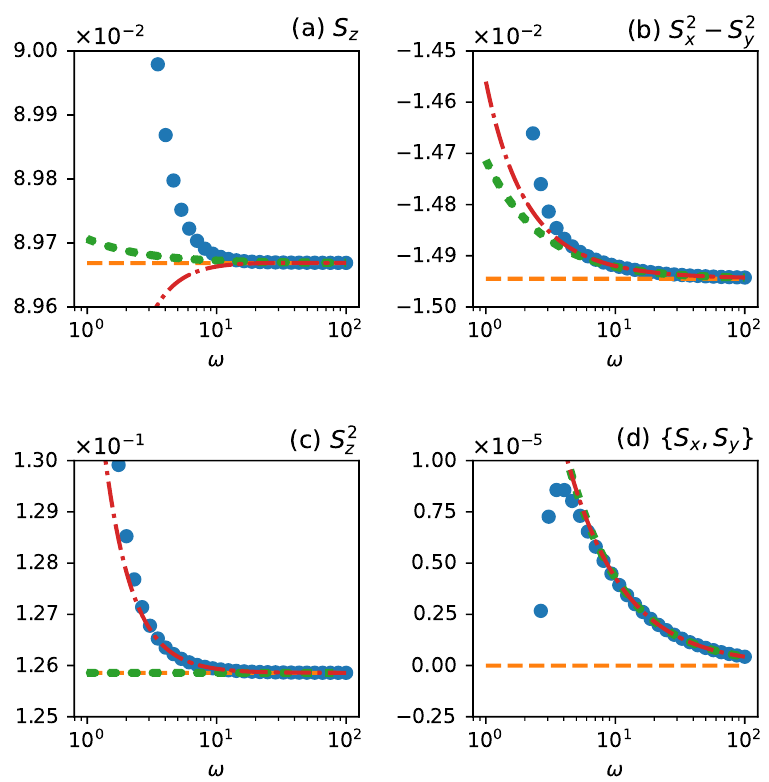
Figure 4: One-cycle averages of observables in the NESS [ Eq. (72) ] plotted against ω . Here ρ ( t ) is calculated by the exact numerical integration (blue) and by the ness HF expansion approach at order 0 (orange), 1 (green), and 2 (red). The parameters are the same as in Fig. 3 except ω .